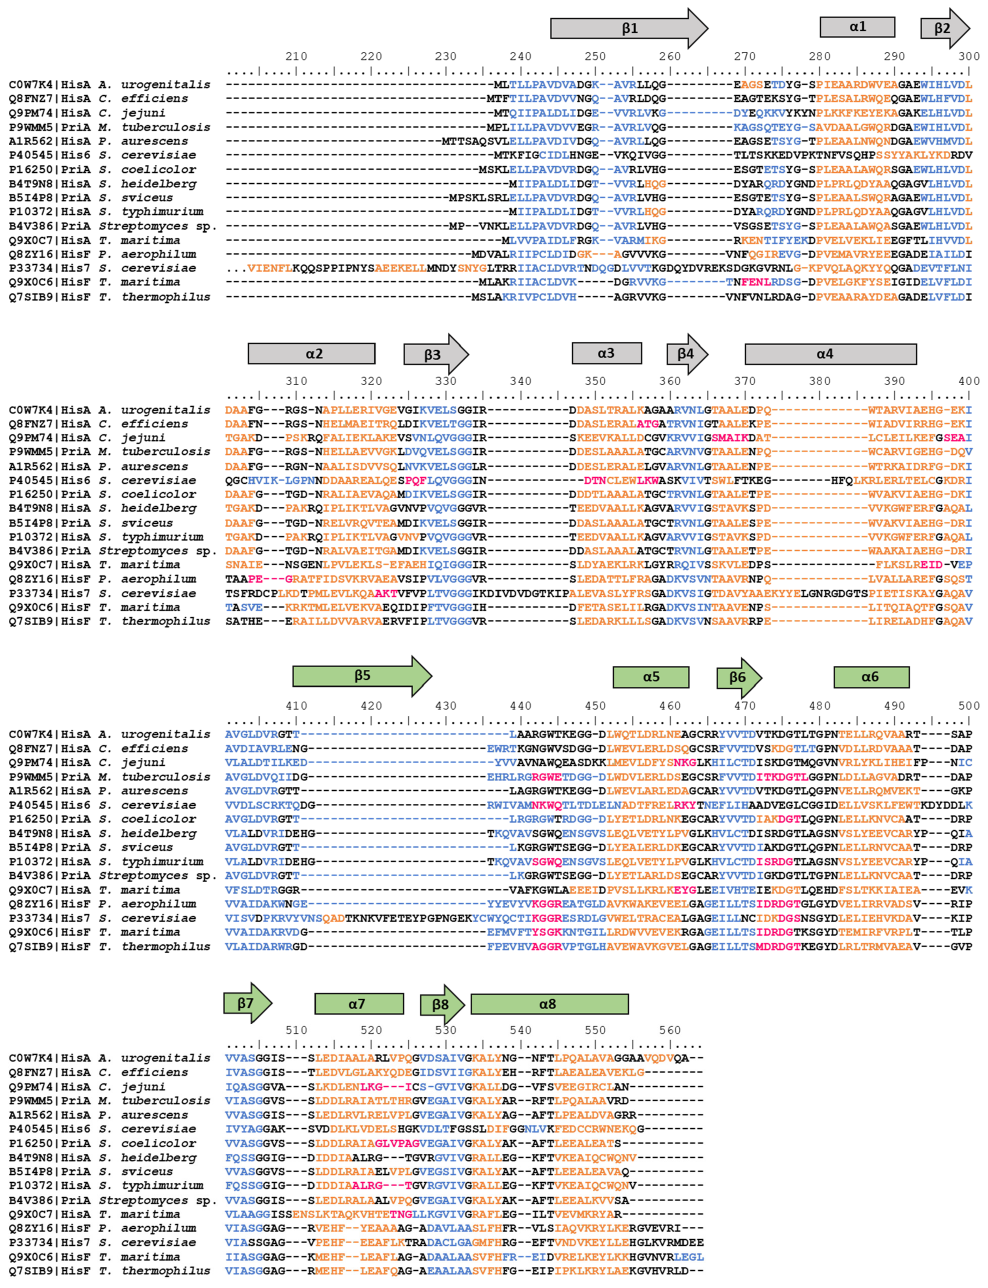
Figure 6. Alignment of the amino acid sequences of HisA, HisF, and relative orthologs reported in the PDB. Secondary structure elements are reported in orange ( α -helices), blue ( β -strands), and fuchsia (turns). α -helices and β -strands are also schematized with rectangles and arrows, respectively; the elongation event is depicted with the two halves of the proteins colored in grey and green.